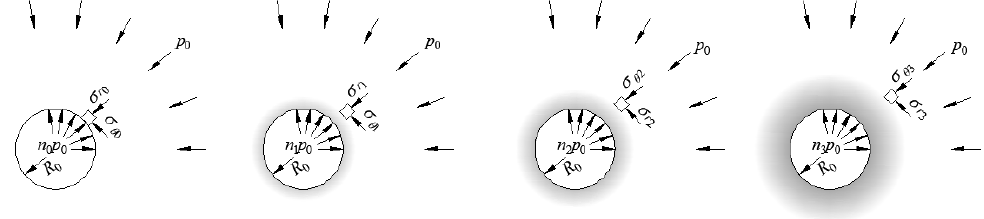
Figure 4. Induced stress reaction distribution of the surrounding rock by shaft sinking [38].